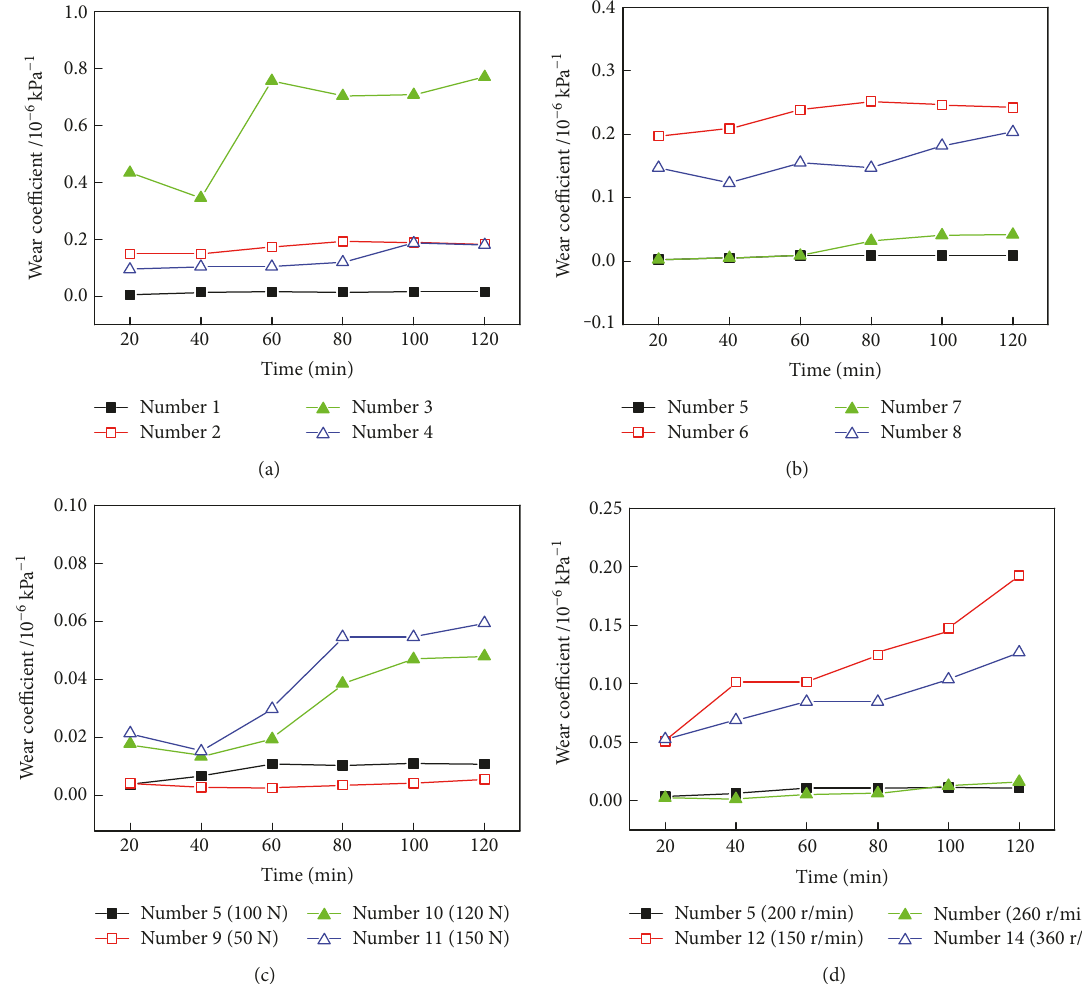
Figure 3: Variations of wear coe ffi cient with time under di ff erent materials (a), surface treatments (b), loads (c), and rotation speeds